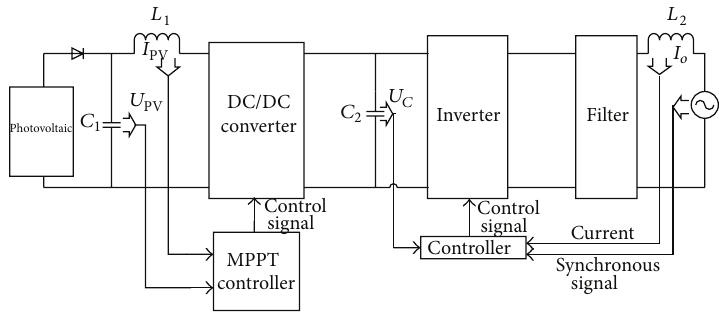
Figure 2: Schematic diagram of maximum power point tracking using boost